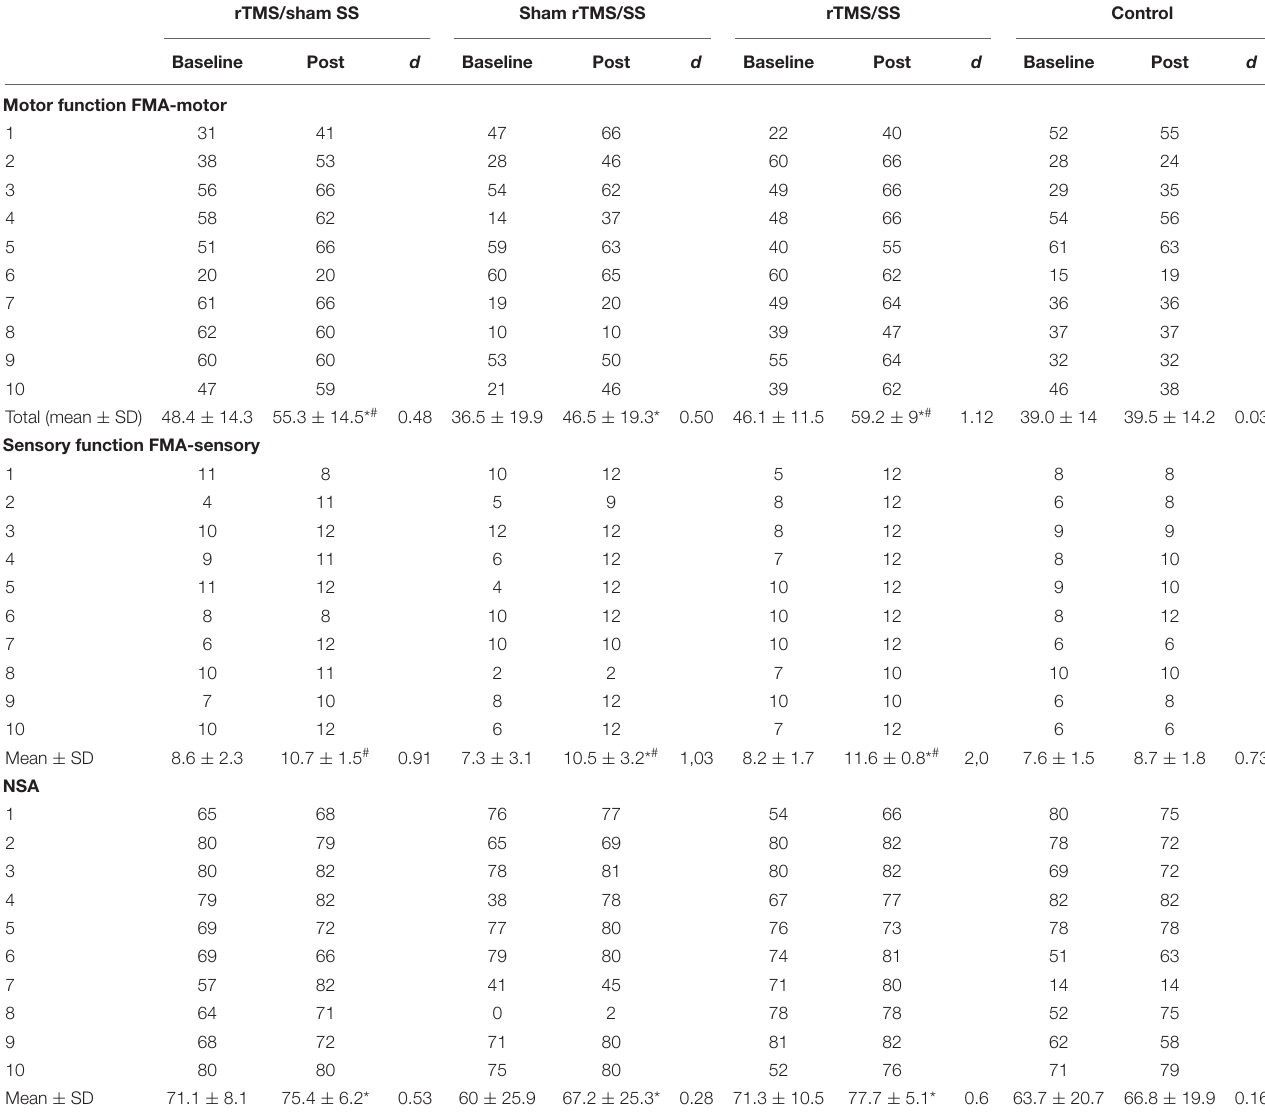
TABLE 2 | Primary Outcomes–Body structure/function domains of the International Classification of Functioning, Disability, and Health (ICF). rTMS/sham SS Sham rTMS/SS rTMS/SS Control Baseline Post d Baseline